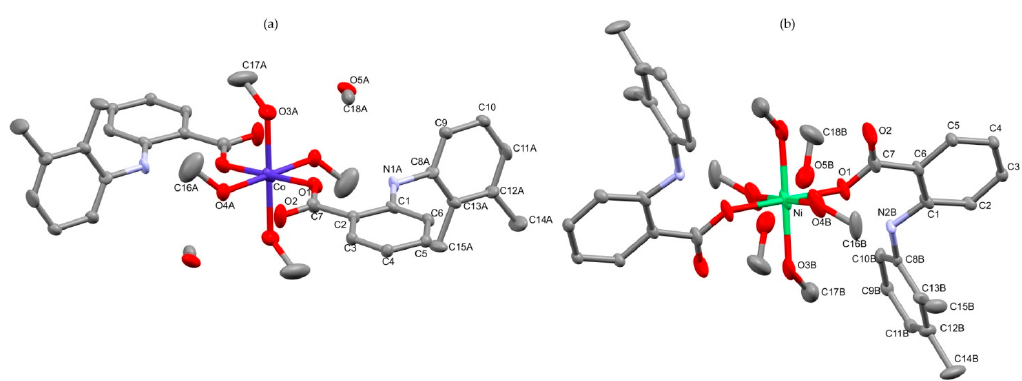
Figure 2. Molecular structures of 3 (a) and 4 (b). Hydrogen atoms are omitted for clarity. Displacement ellipsoids are drawn at the 50% probability level. Only asymmetric units are labeled.